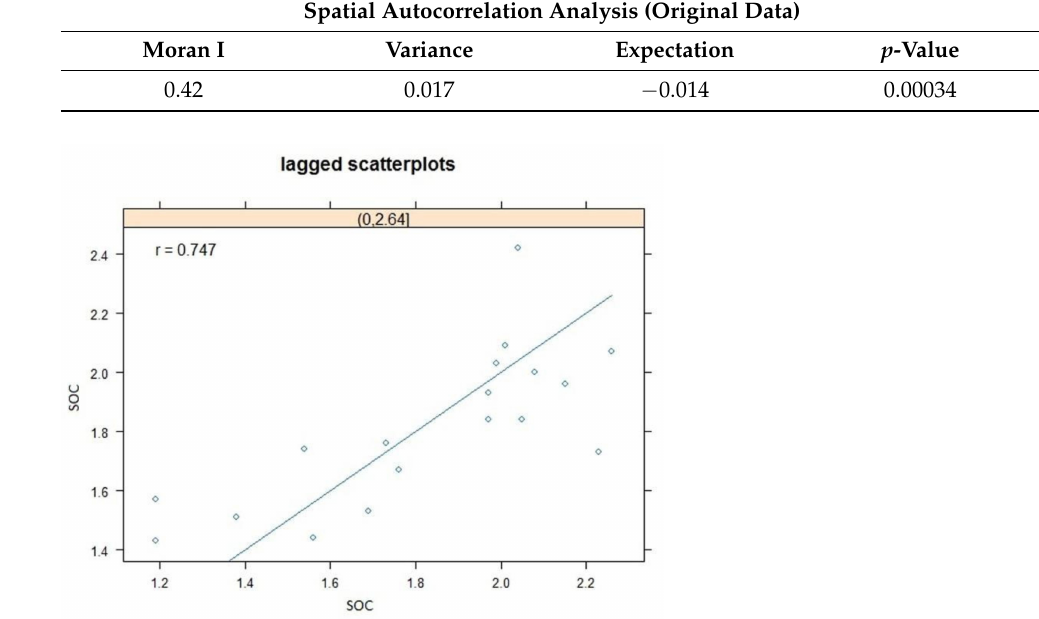
Table 2. Assessment of the global Moran index.